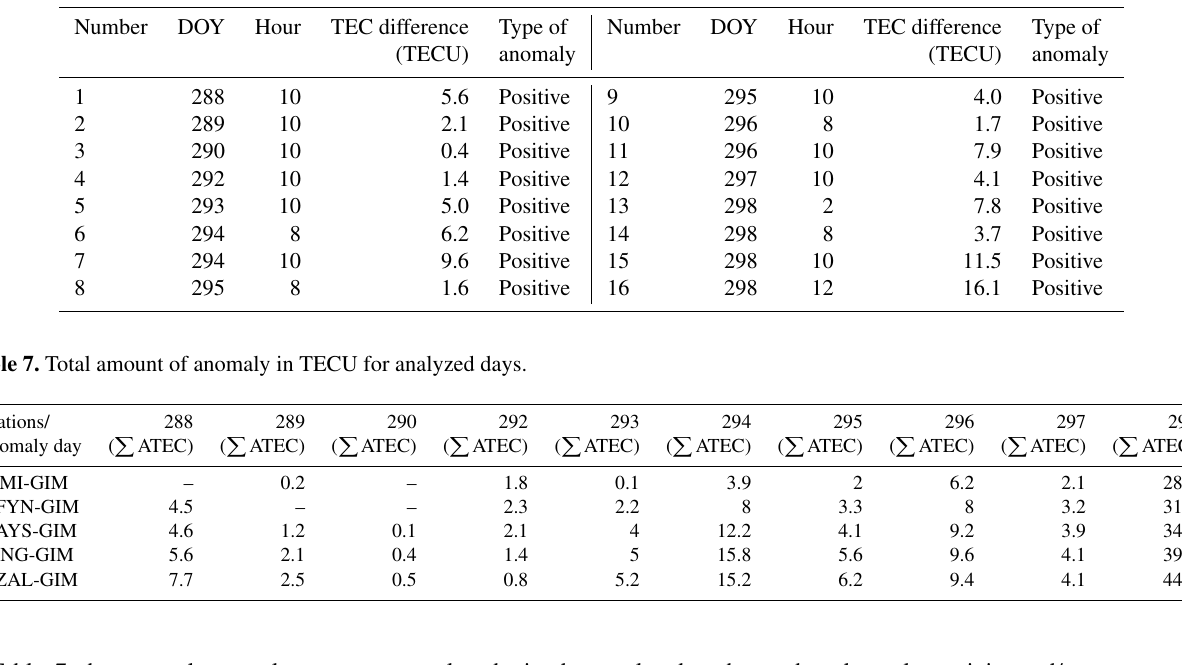
GIM-TEC anomaly table for BING Station